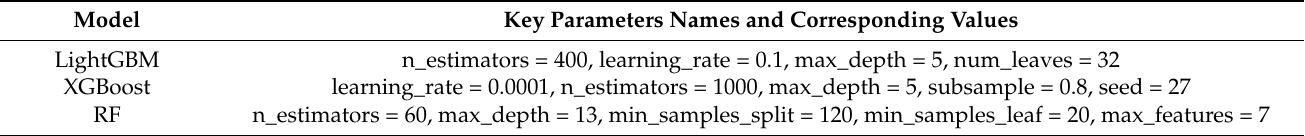
Table 1. The key parameters optimization results of the ensemble learning models. Notes: RF: Random Forest. Model Key Parameters Names and Corresponding Values LightGBM